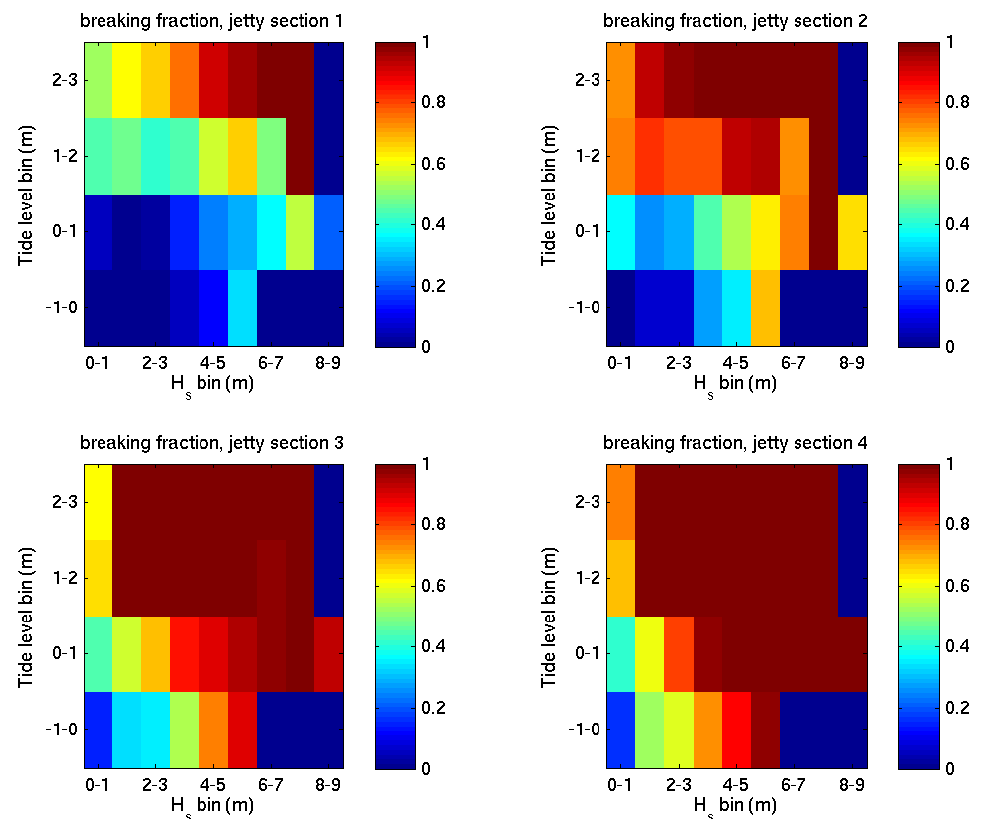
Figure 10. Bulk fraction of breaking over the jetty region as a function of significant wave height (x-axis) and tide elevation (y-axis). Blue regions at very large wave heights are due to there being no examples in these bins.